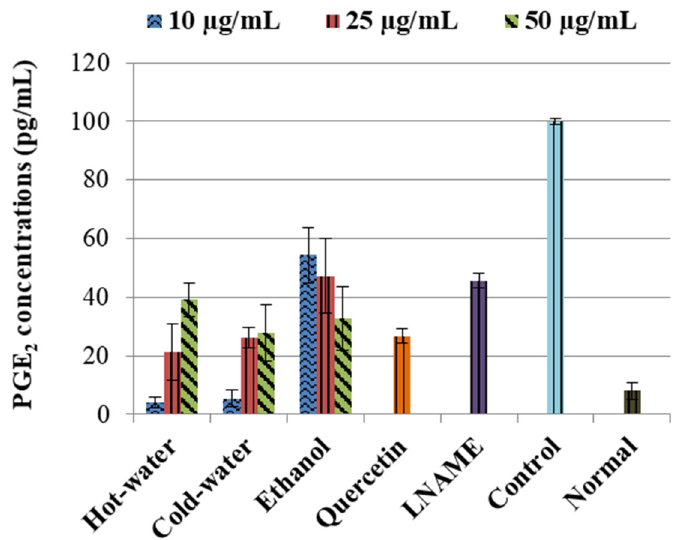
Figure 2. Inhibitory effects of P. natalensis extracts on LPS-induced PGE 2 production on RAW 264.7 macrophages treated with different concentrations (10, 25 and 50 µg/mL) and positive controls; quercetin (50 µg/mL) and LNAME (100 µM) over 24 h.